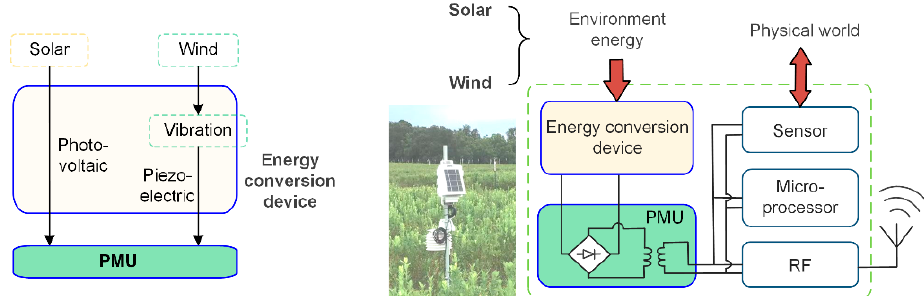
Figure 1. Structural chart of the operation principle of an energy conversion device and a typical autonomous sensing device.